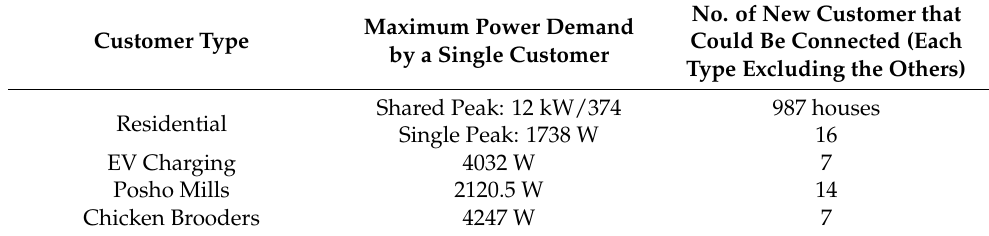
Table 9. Maximum number of new customers using peak power demand